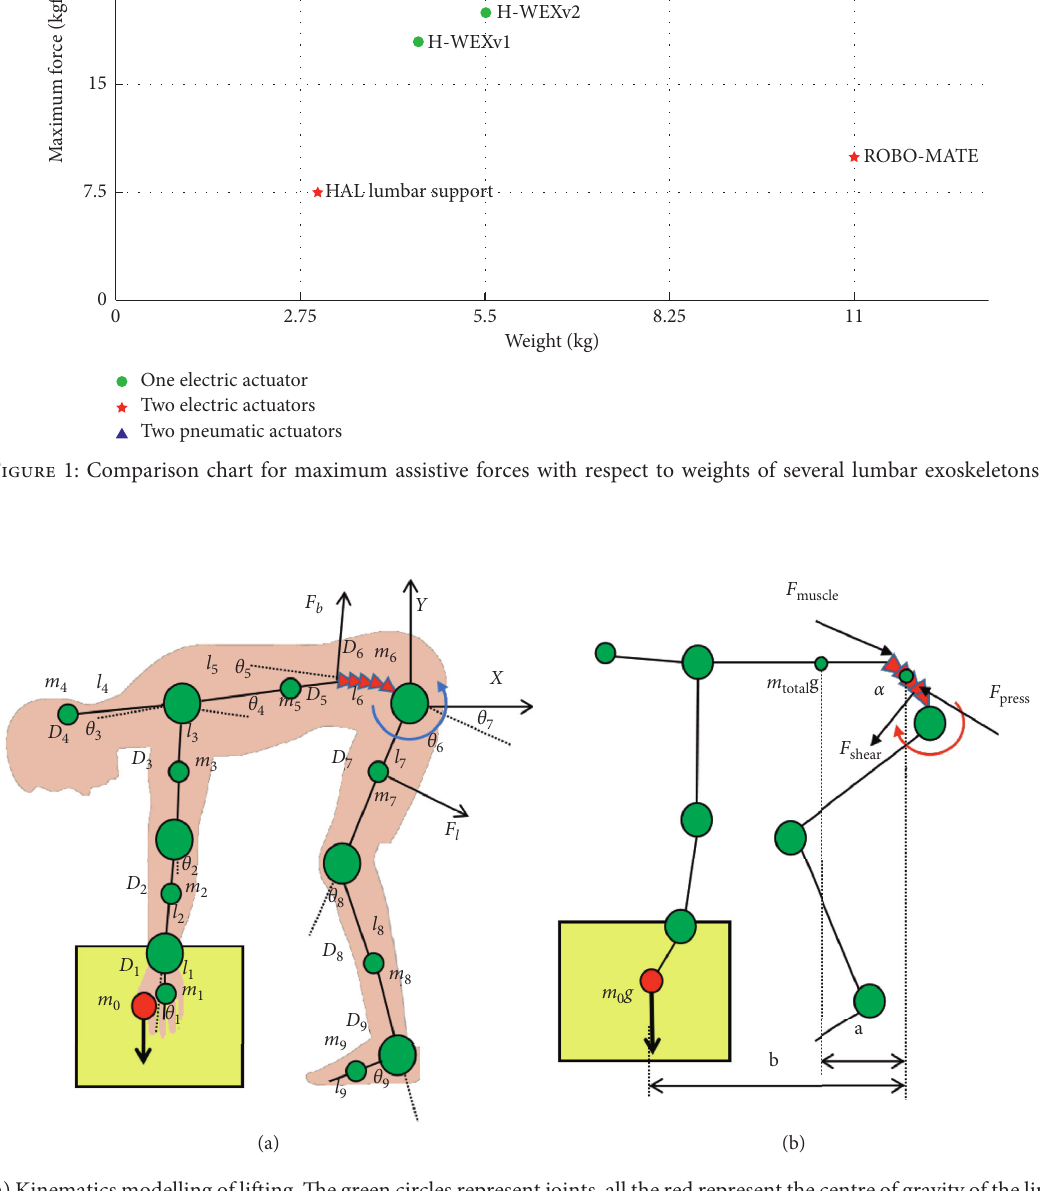
Figure 2: (a) Kinematics modelling of lifting. The green circles represent joints, all the red represent the centre of gravity of the limb, the five red triangles represent the L 1 - L 5 lumbar vertebrae of the users from left to right, D i represents the centre of mass of the limb, m i represents the mass of limb, l i represents the length of the limb, and θ i indicates an angle between limbs; (b) simplified mechanical model of lifting. Since the model (a) is too complicated, we simplify it to analyse its dynamic properties.